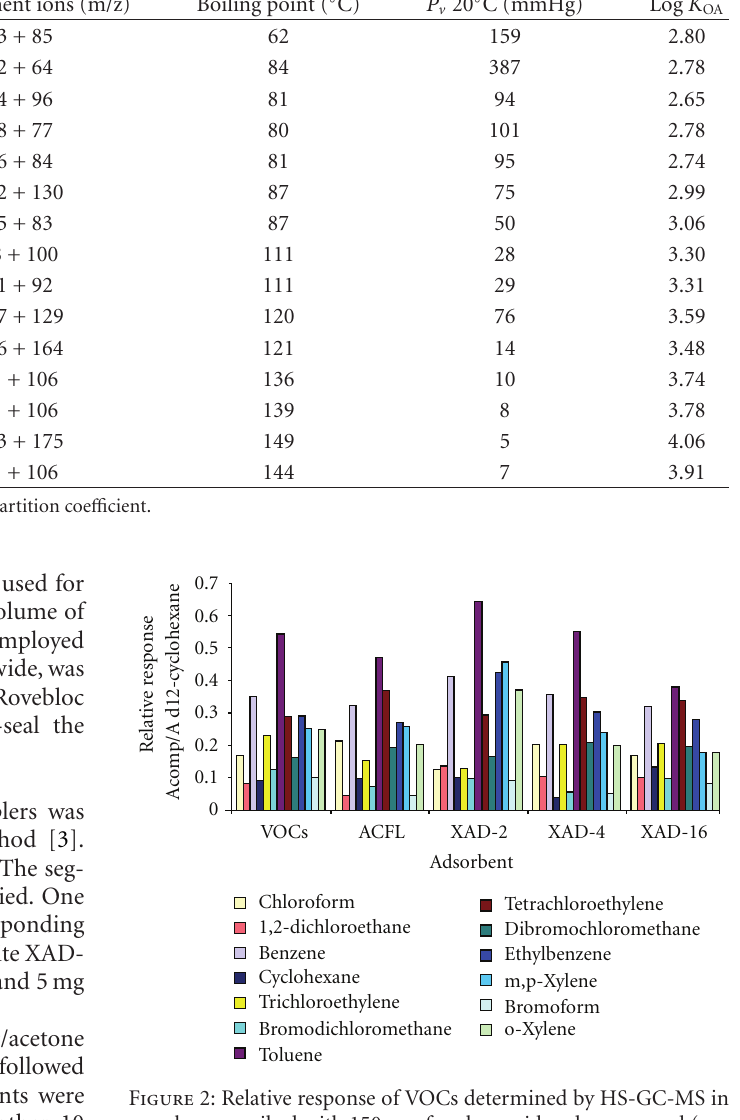
XAD-16 and active carbon-florisil inside closed 2.85 ± 0.01